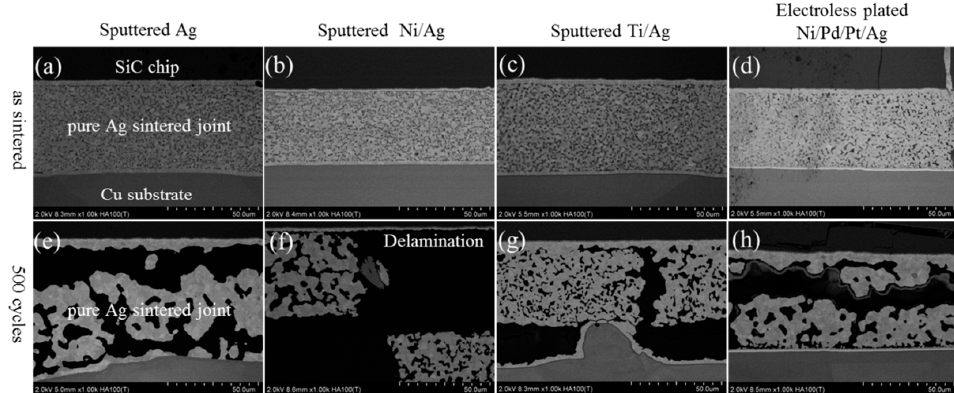
Figure 9. Evolution of pure Ag sintered joint with various substrates in as-sintered state and after a TC test of 500 cycles: ( a – d ) as sintered state, ( e – h ) after 500 cycles.